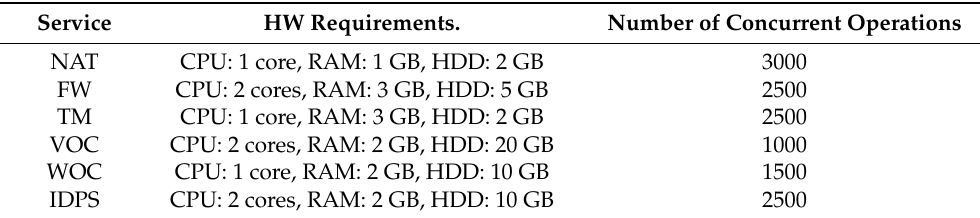
Table 3. Hardware requirements associated to the VNFs